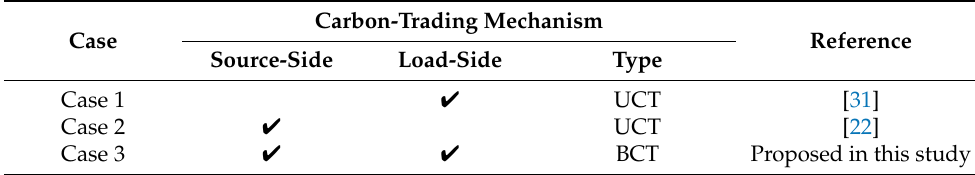
Table 5. Three cases with different carbon-trading mechanisms.